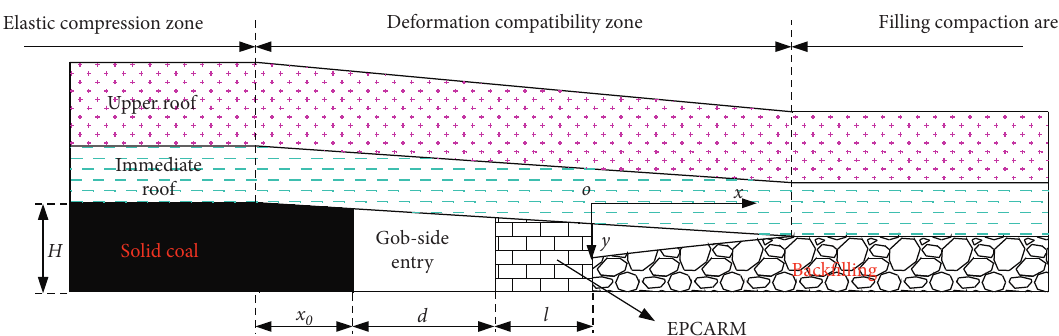
Figure 2: Partition model of interaction between the roof and filling body under the filling